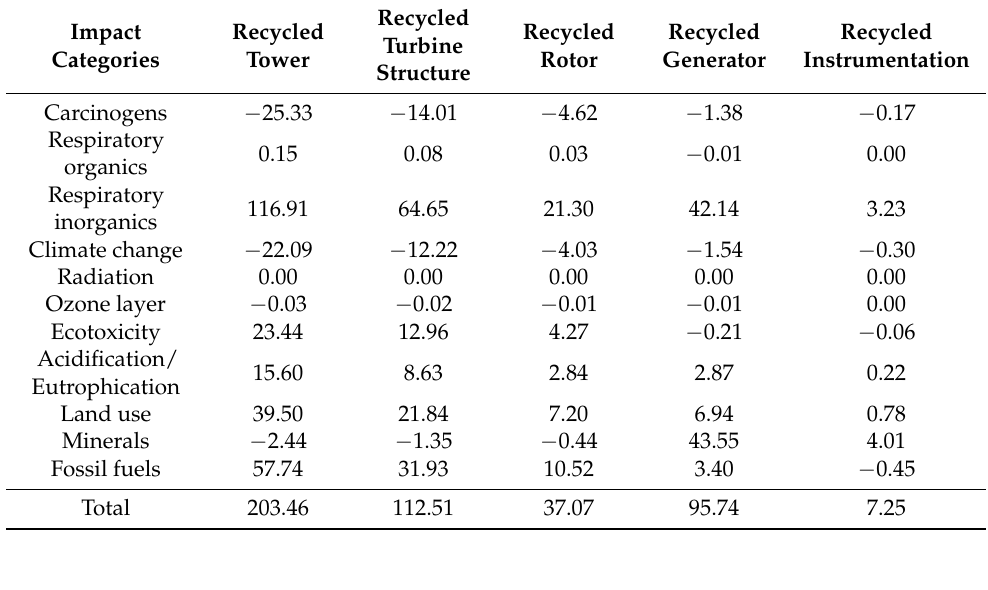
Table 3. Results of grouping and weighting of environmental impacts during the life cycle of an innovative 15 kW wind turbine—method with recycling (unit: Pt/1 p).